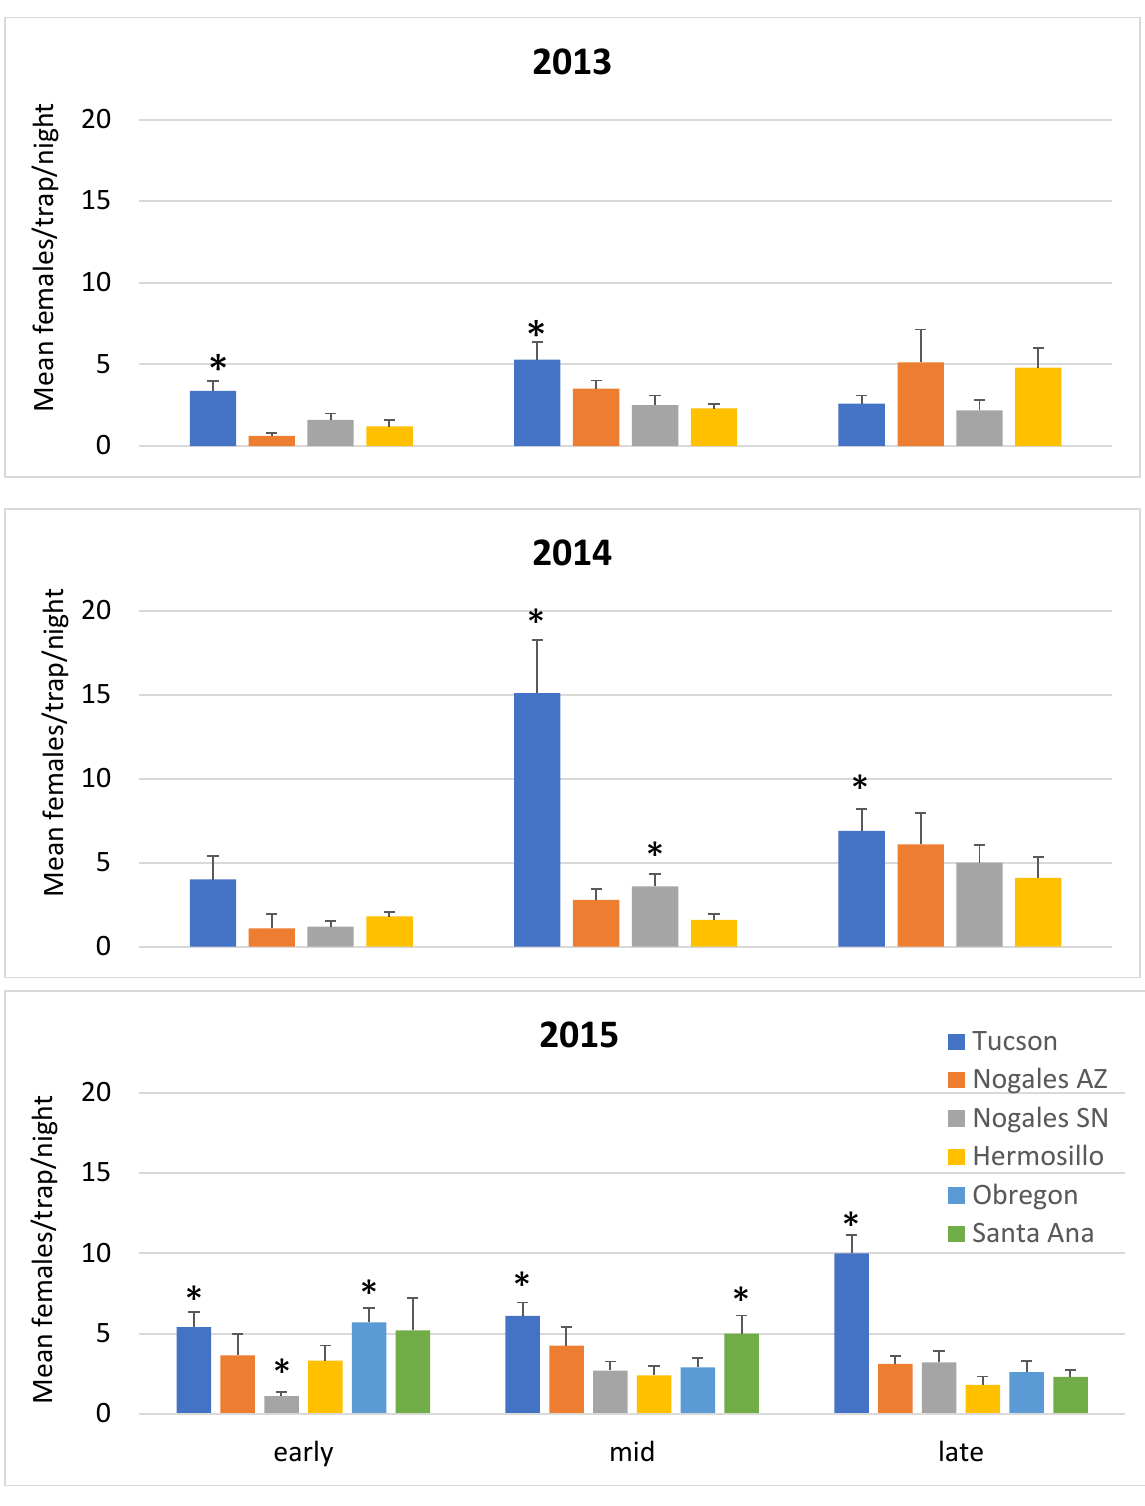
Figure 4. Average female mosquito trap catches by city and sampling period (early = Jul 15 to Aug. 14; mid = Aug. 15 to Sept. 14; late = Sept. 15 to Oct. 14) for years 2013 to 2015. An asterisk * denotes a city with mosquito counts that are significantly different ( p < 0.05) from the reference city, Hermosillo (in yellow).